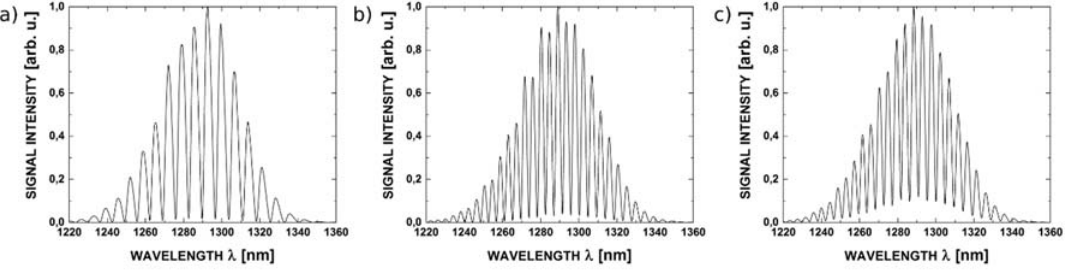
Figure 12. Measurements of different chemical substances, Fabry-Pérot cavity length 100 µm, at wavelength 1300 nm: ( a ) reference for clean Ag mirror; ( b ) cyclohexane and ( c ) toluene.